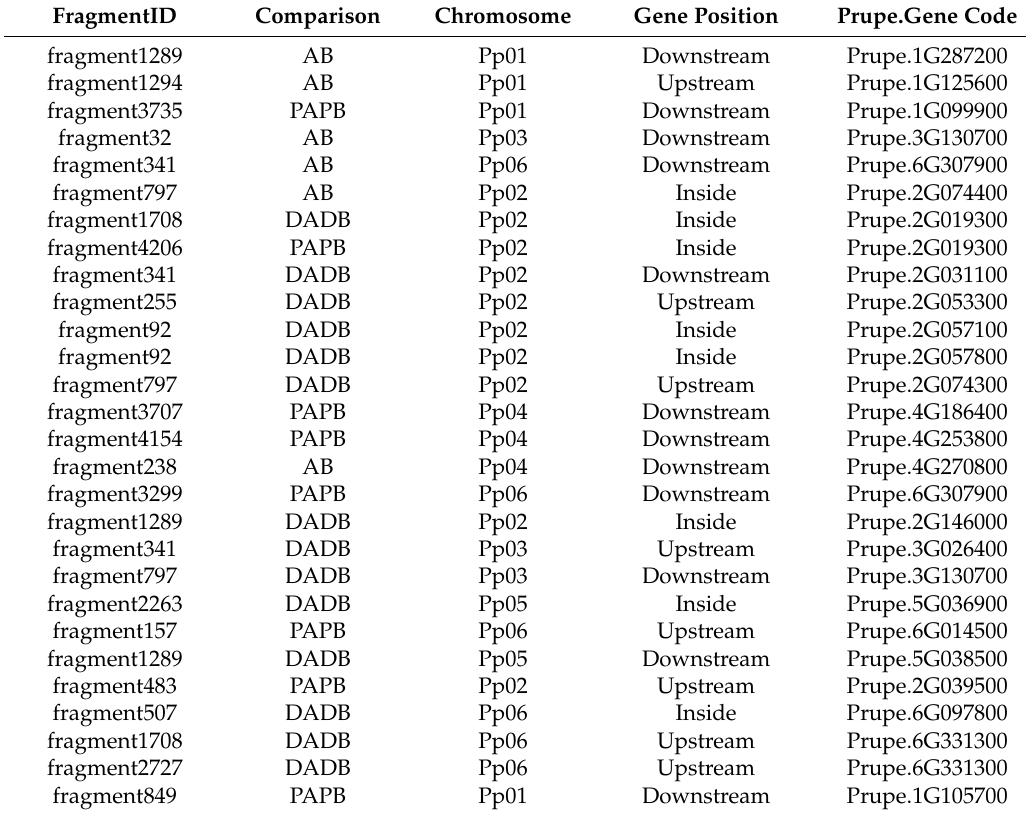
Table 4. Hypermethylated genes identified in ‘Desmayo Largueta’ (D) and ‘Penta’ (P) stage A flower buds compared to those found in stage B flower buds (Chromosome, Fragment ID, Prupe.ID, Functional